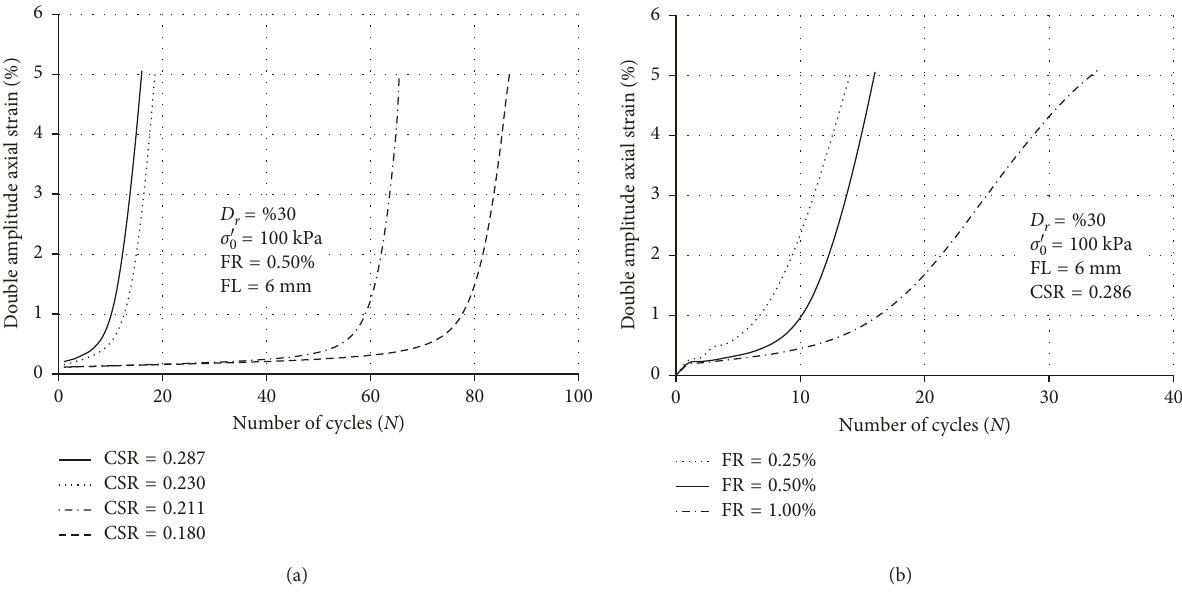
Figure 14: Pore-water pressure ratio (PWP) versus cycle ratio number ( N / N by using α coefficients from the model proposed by Polito et al. [34].